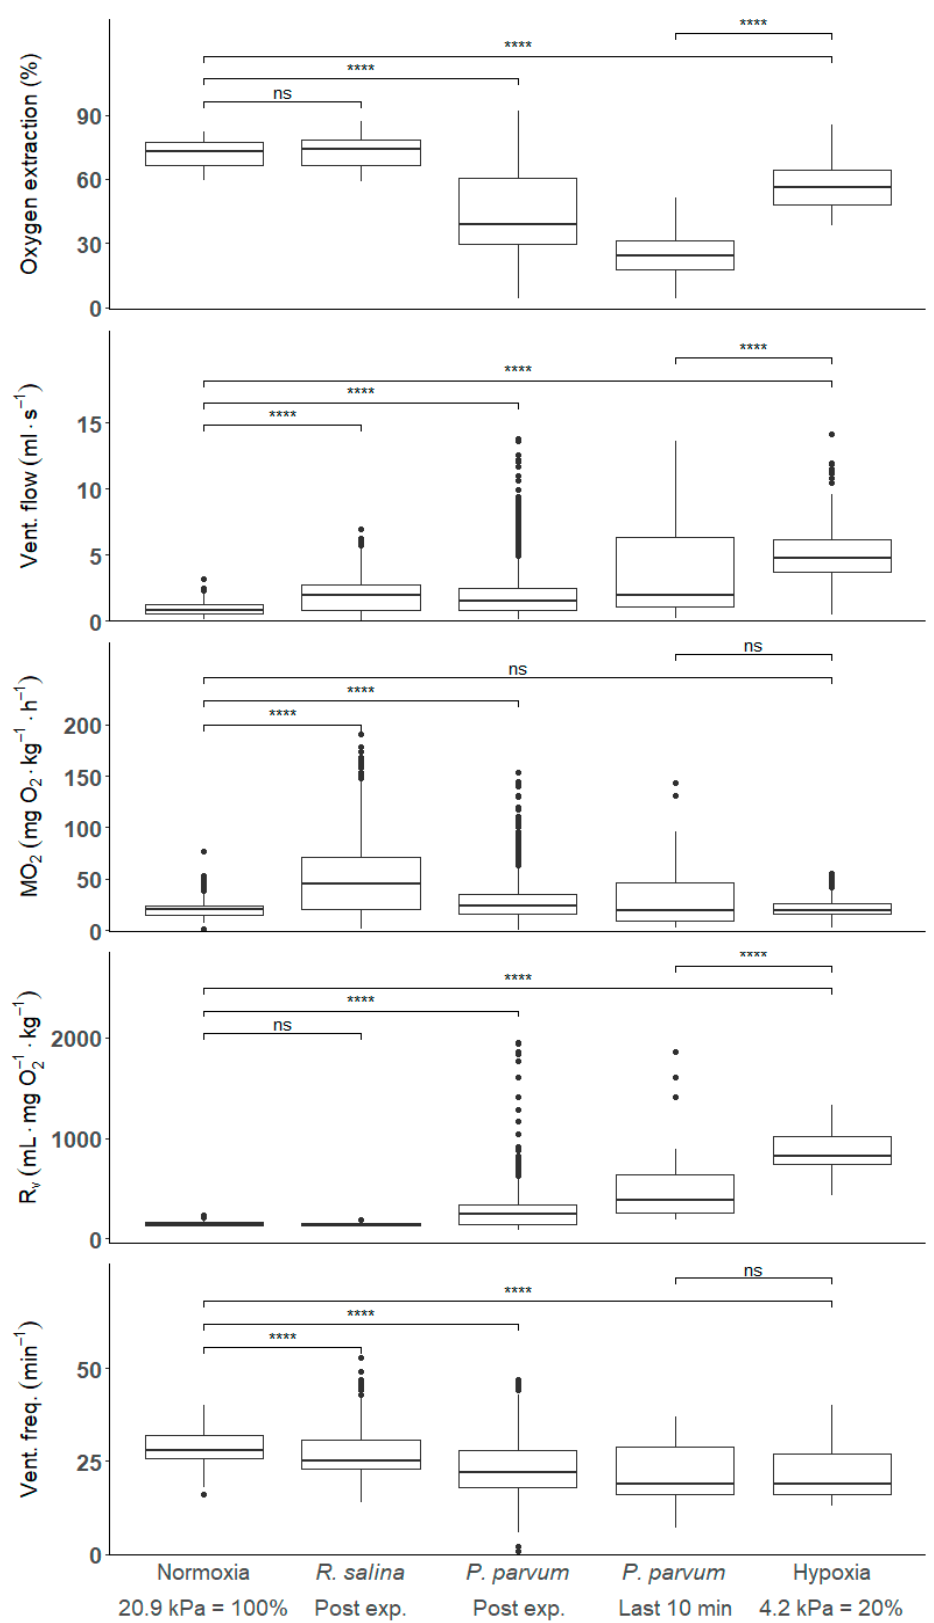
Figure 1. Respiratory parameters during the different stages of each experiment. All values are given as median ± SD. ( a ) Oxygen extraction, ( b ) Ventilatory flow, ( c ) Oxygen consumption, ( d ) Ventilatory requirement, and ( e ) Ventilation frequency. The significance levels are shown as asterisks (*).